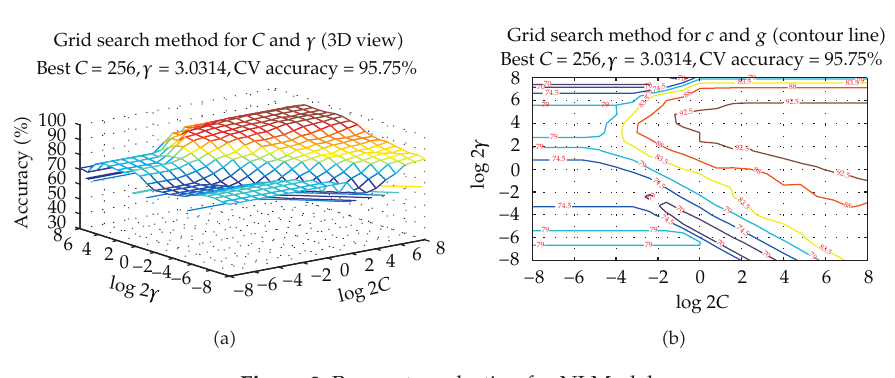
Figure 3: Parameter selection for NLModel.